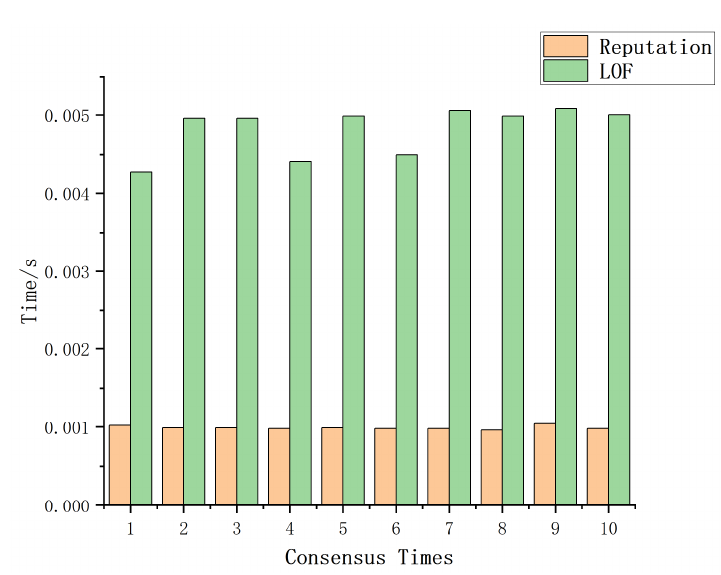
Figure 14. Reputation and time